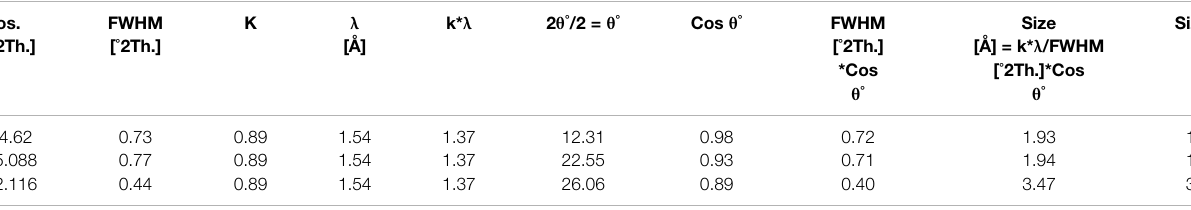
TABLE 2 | XRD spectral data for olive oil.